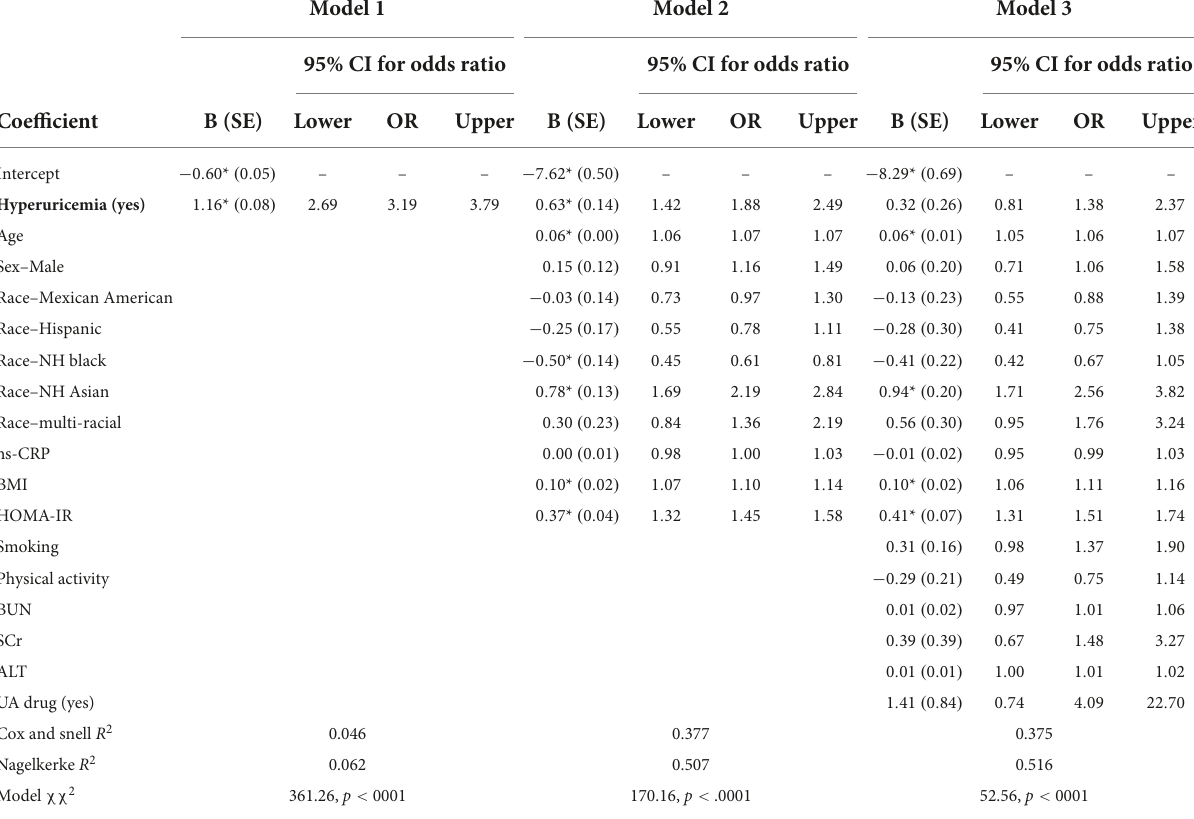
TABLE 3 Logistic Models demonstrating the odds of having metabolic syndrome